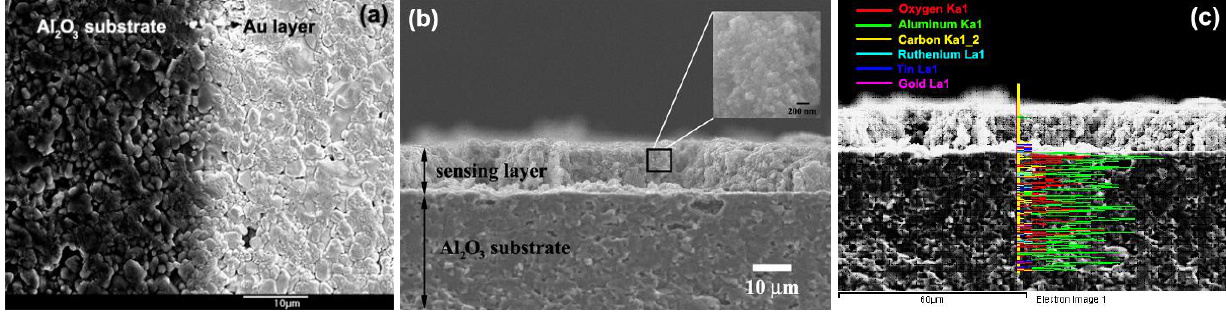
Figure 8. (a) the phase boundaries of microstructures of high density Al left) substrate interdigitated with Au electrodes (bright view, right), (b) The film